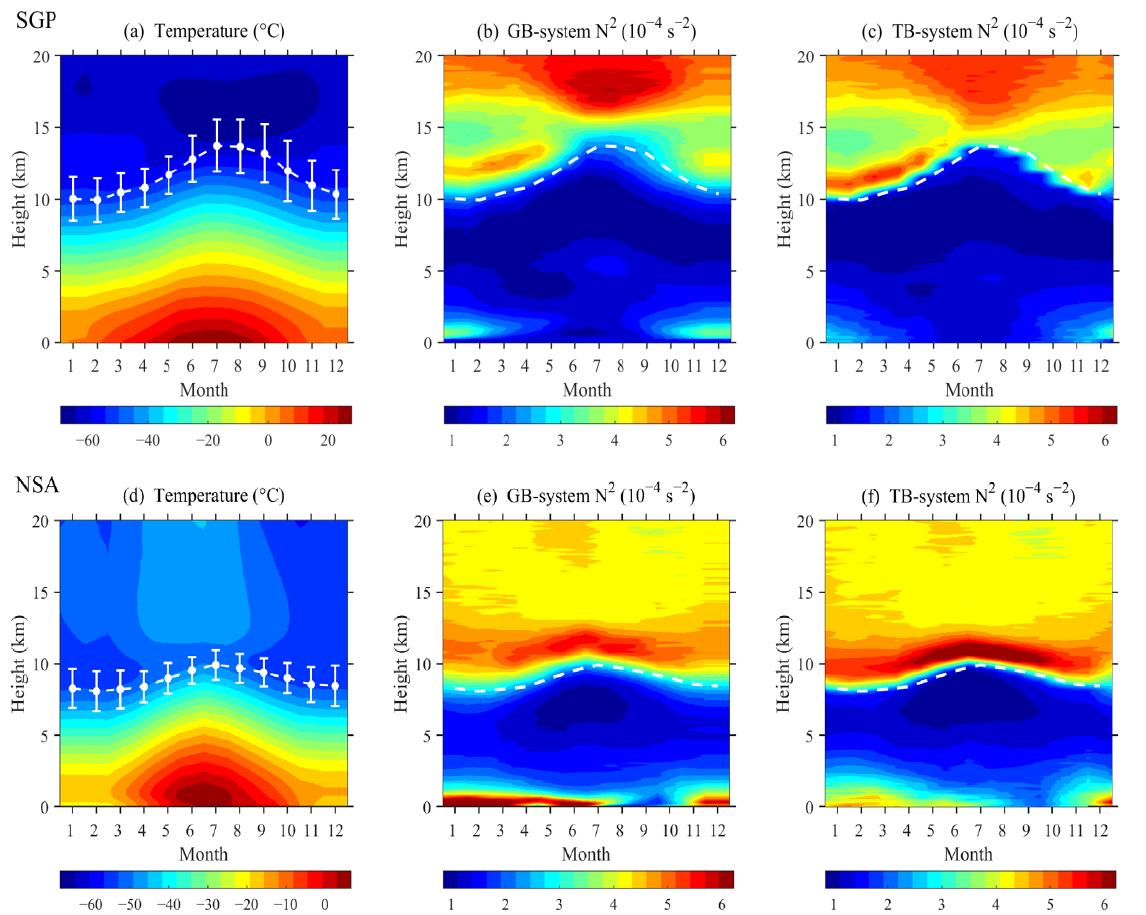
Figure 3. Monthly averaged climatologies of the temperature ( a ) and stability with respect to the ground level ( b ) and with respect to the tropopause heights ( c ) at SGP; panels ( d ), ( e ) and ( f ) are similar to ( a ), ( b ) and ( c ) but at NSA. The white line in each panel shows the monthly variation in the tropopause height, with the stand deviation presented in the left two panels.